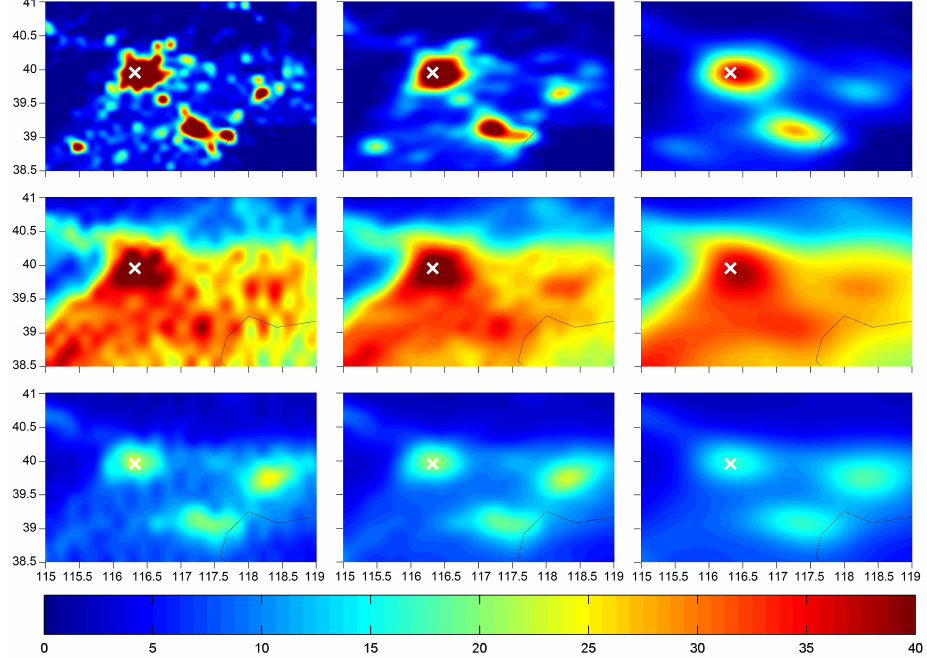
Fig. 16. Illustration of the “smoothing effect”. Proxies for the “true” spatial distribution of NO 2 (left) are re-sampled by satellite pixels of 26 × 13km 2 (center) and 60 × 30km 2 (right). Proxies are nighttime lights (top) in artificial units, and seasonal mean NO 2 distributions from OMI for winter (middle) and summer (bottom) in units of 10 15 moleculescm − 2 . The white cross indicates the MAX-DOAS measurement